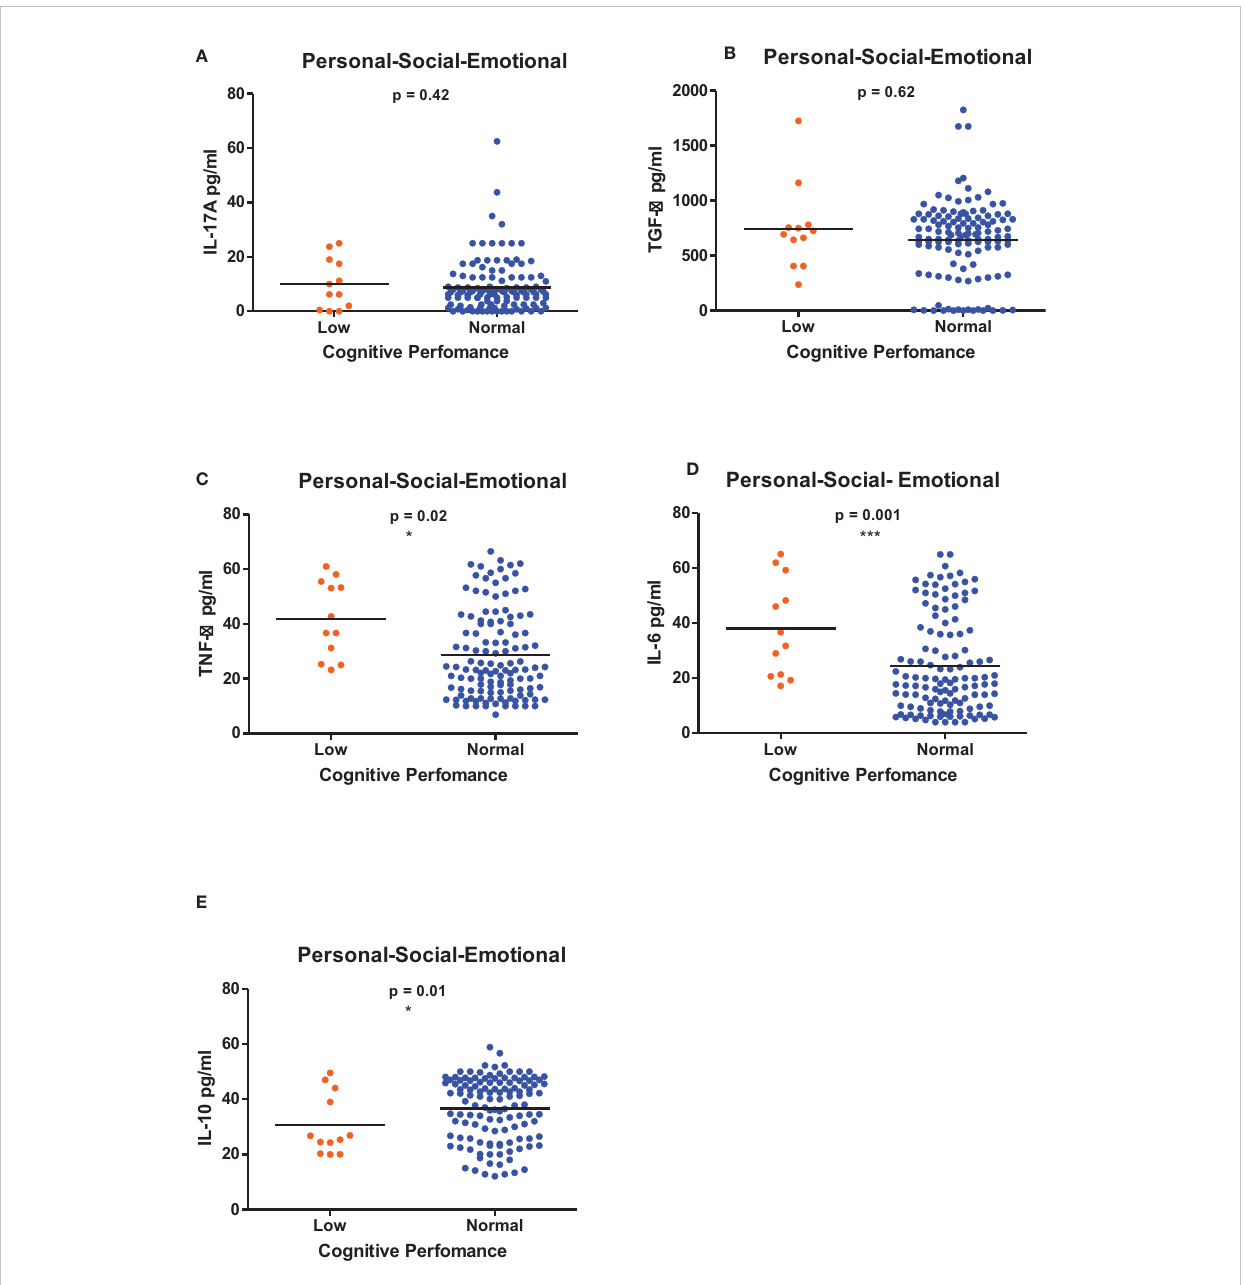
FIGURE 4 (A-E) Cytokine concentration level comparisons between low and normal PSAC performers in the Personal-Social-Emotional Domain using the Wilcoxon matched-pairs signed rank test. * = p ≤ 0.05, *** = p ≤